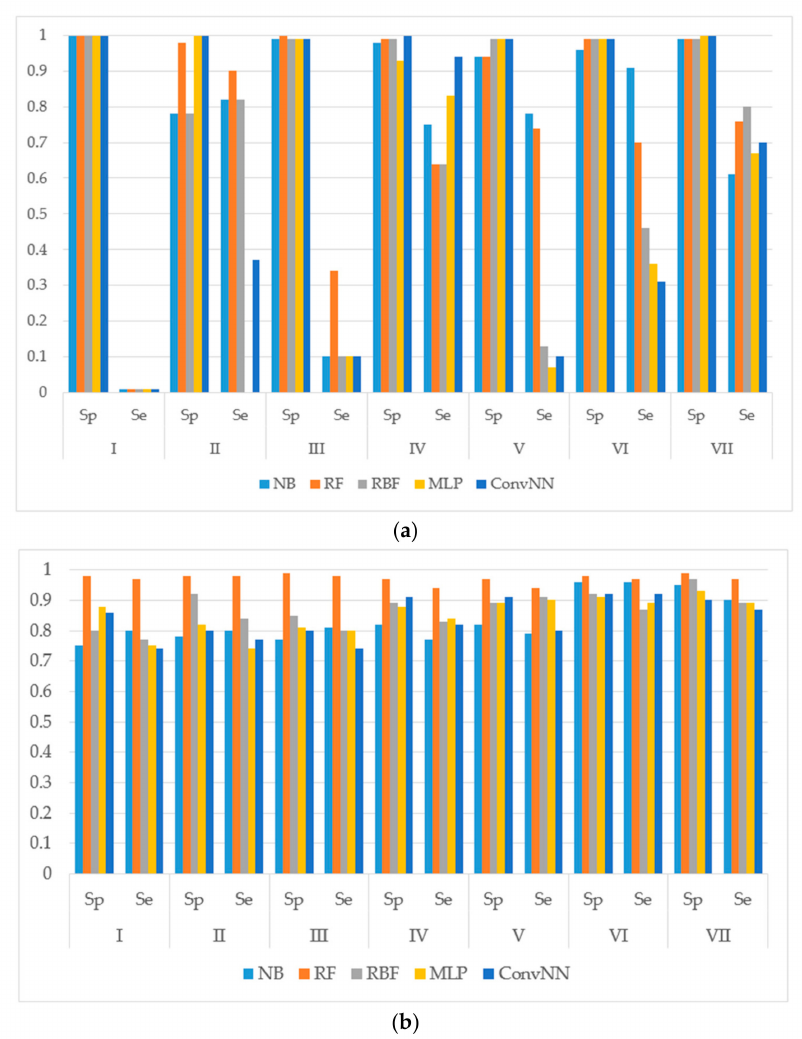
Figure 1. Sensitivity (Sp) and specificity (Se) of the classification models for SOM predictions of the datasets compiled according to the type of metabolizing reaction: ( a ) datasets before balancing; and ( b ) balanced datasets. X-axis: Roman numerals correspond to the following reaction types I: aliphatic-hydroxylation; II: aromatic hydroxylation; III: C -oxidation; IV: N -dealkylation; V: N -oxidation; VI: O -dealkylation; and VII: S -oxidation. Machine learning algorithms: RF: random forest; RBF: radial basis function network; MLP: multilayer perceptron; Conv. NN: convolution neural network; AUC: area under the received operating characteristic curve. Y-axis: Sp is obtained as: TP/(TP + FN). Se is obtained as TN/(TN + FP). TP: Number of true positive predicted samples; FP: number of false positive; TN: number of true negative; FN: number of false